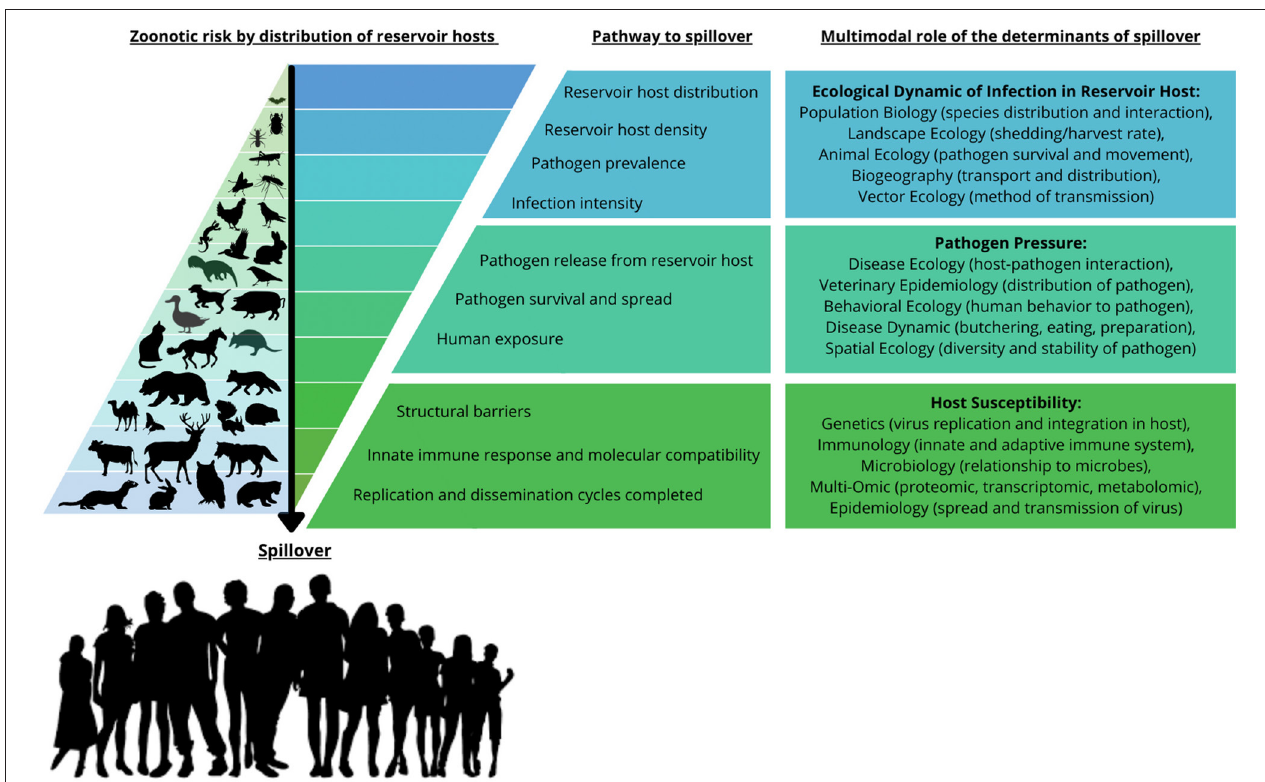
FIGURE 1 | Zoonotic risk distribution, pathway to spillover, and the multimodal role of the determinants of spillover. The zoonotic risk is demonstrated by the accumulated distribution of reservoir hosts and vectors that play a role in the pathway to spillover. The risk of spillover is determined by a series of processes from the ecological dynamics of reservoir host distribution and density, to the susceptibility, replication and dissemination of the biological factors in the recipient host. This is also reflected in the multimodal role of the determinants of spillover, demonstrating the disciplines that are being used to study zoonotic transmission and the determinants of spillover. This figure was adapted from Figure 1 in Plowright et al. ( 2). Copyright permission was obtained with license number